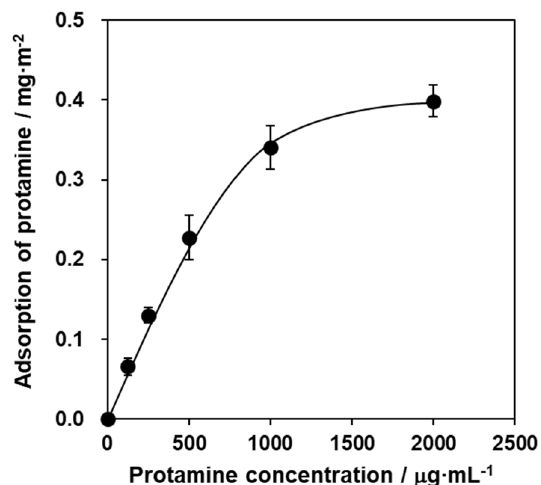
Figure 1. Adsorption levels of protamine to hydroxyapatite (HAp) powders. HAp powders were mixed with various concentrations of protamine solutions for 48 h. Adsorption of protamine was determined by residue of protamine in supernatants using the Bio-Rad protein assay. Each value represents the mean of triplicate tests. Error bars indicate the standard error of the mean.